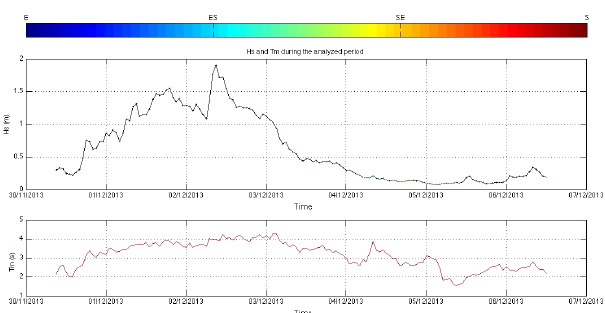
Figure 5. Time series of the 7th storm.